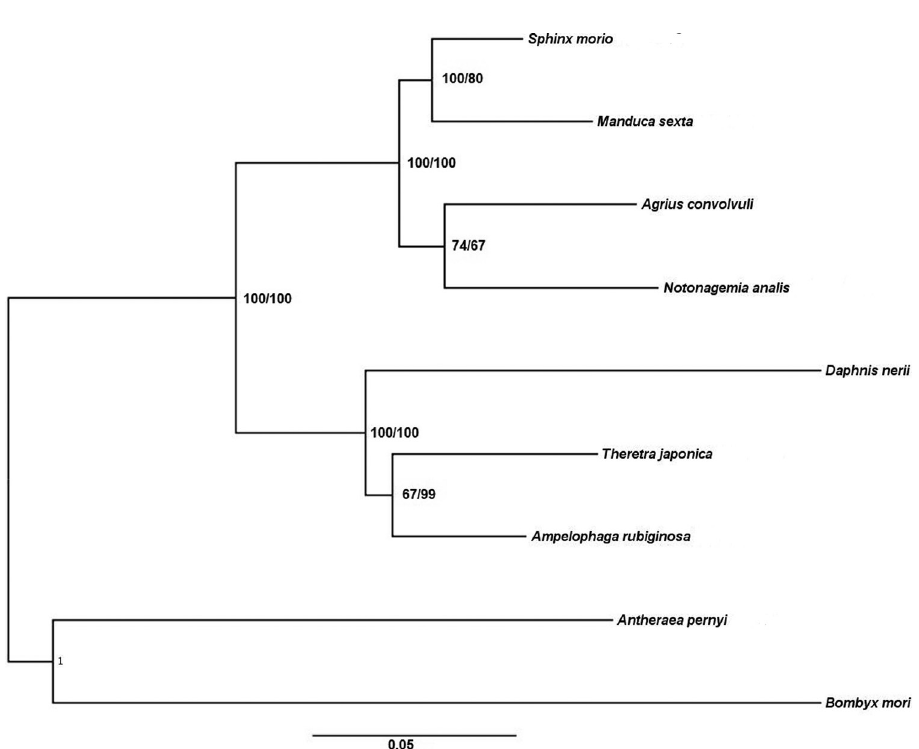
Figure 7. Phylogenetic analysis. Phylogenetic tree constructed using NJ and ML methods based on the amino acid sequences of 13 PCGs of 7 species with Bombyx mori (Lepidoptera: Bombycidae) and Anthe- raea pernyi (Lepidoptera: Saturniidae) as outgroups. The support values at the nodes represent bootstrap values for NJ and ML